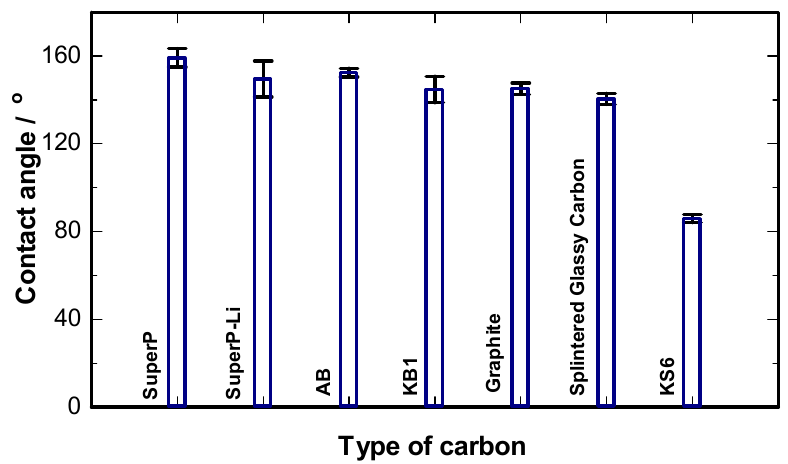
Figure 3. Advancing contact angle measurement of water on the cathodes using di ff erent types of carbon.